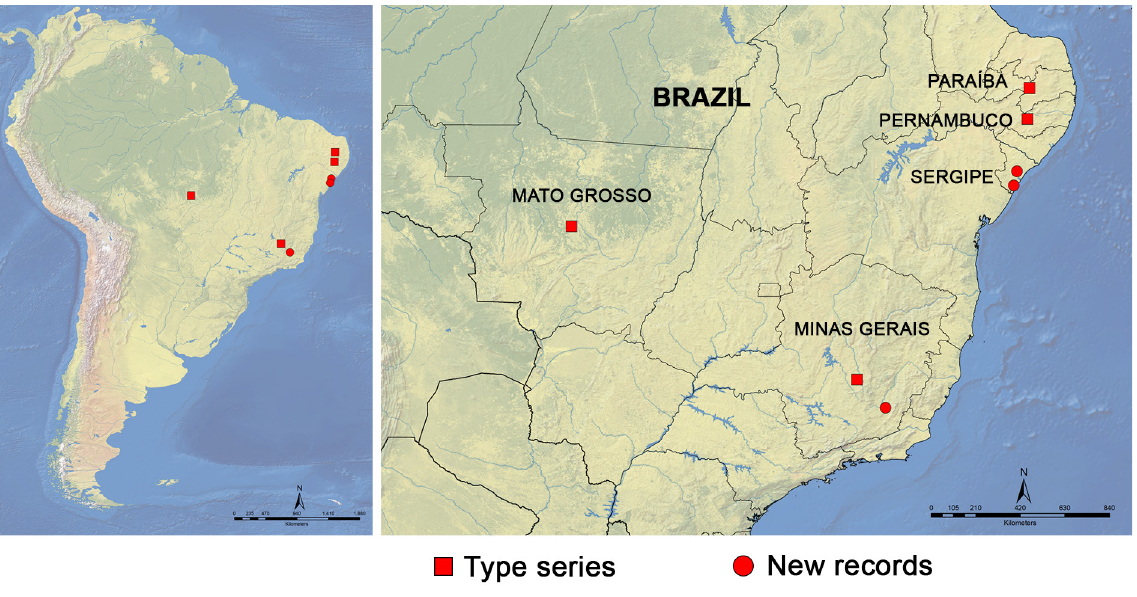
Fig. 55. Cyparium collare Pic, 1920, distribution. Squares = literature; circles = new